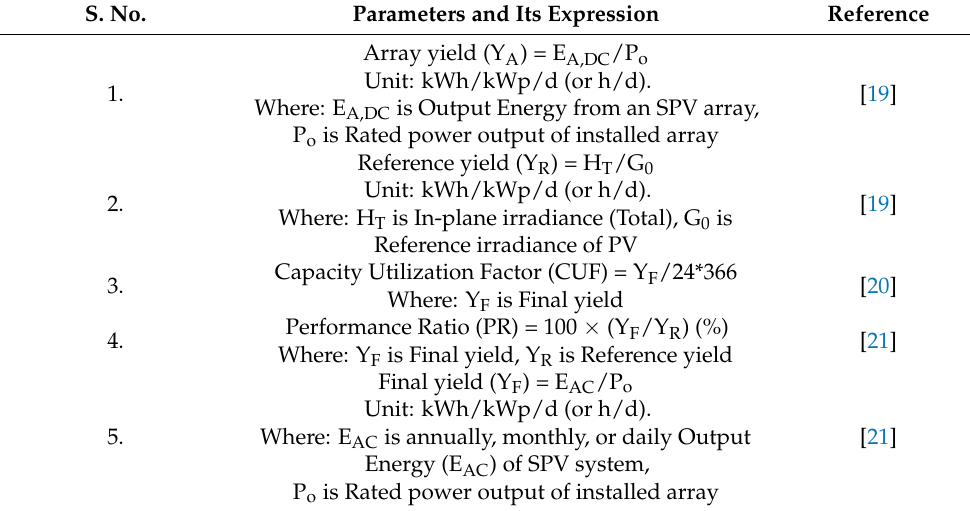
Table 1. Performance parameters of globally available SPV system. S. No.